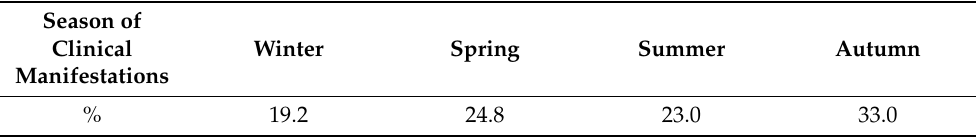
Table 3. Seasonal distribution of the clinical manifestations of human dirofilariasis, Nizhny Nov- gorod, 2012.